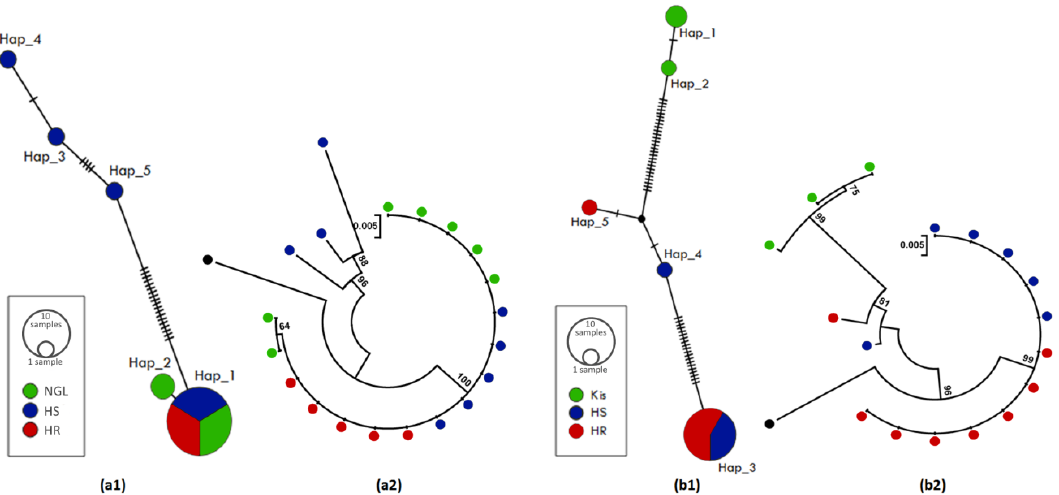
Figure 3. Patterns of the genetic variability and polymorphism of the upstream region of CYP6M2 . ( a1 ) TCS-network of the An. coluzzii sequences showing haplotypes and their respective frequencies (Hap_1, inset); ( a2 ) a maximum likelihood phylogenetic tree of An. coluzzii sequences generated using Tamura 3-parameter model; ( b1 ) TCS-network of the An. gambiae sequences showing haplotypes and their respective frequencies (Hap_3, inset); ( b2 ) a maximum likelihood phylogenetic tree of An. gambiae sequences generated using Tamura 3-parameter model. Hap, Haplotype; NGL, Ngousso lab strain; HR, Highly resistant; HS, Highly susceptible; Kis, Kisumu lab strain. Table 2. Summary statistics for full CYP6M2 -gene polymorphism in permethrin highly susceptible and highly resistant.